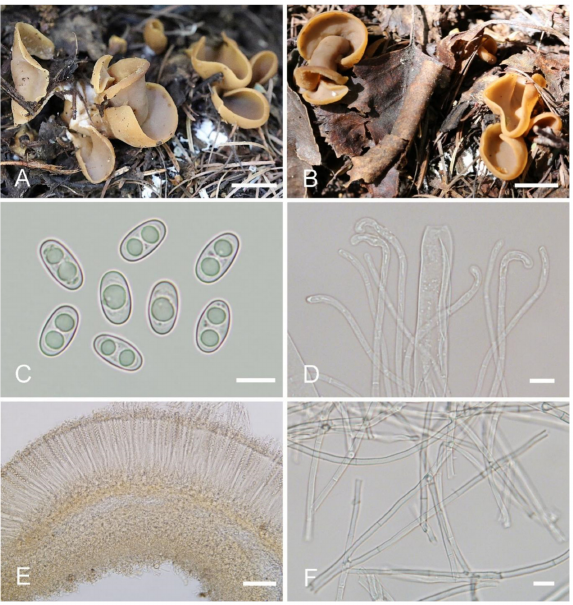
Figure 7. Otidea parvula (BJTC FM210-A) ( A , B ) apothecia, ( C ) ascospores, ( D ) paraphyses and asci, ( E ) anatomy of apothecium, and ( F ) basal mycelium. Scale bars: ( A , B ) = 1 cm, ( C , D ) = 10 µ m, ( E ) = 100 µ m, ( F ) = 10 µ